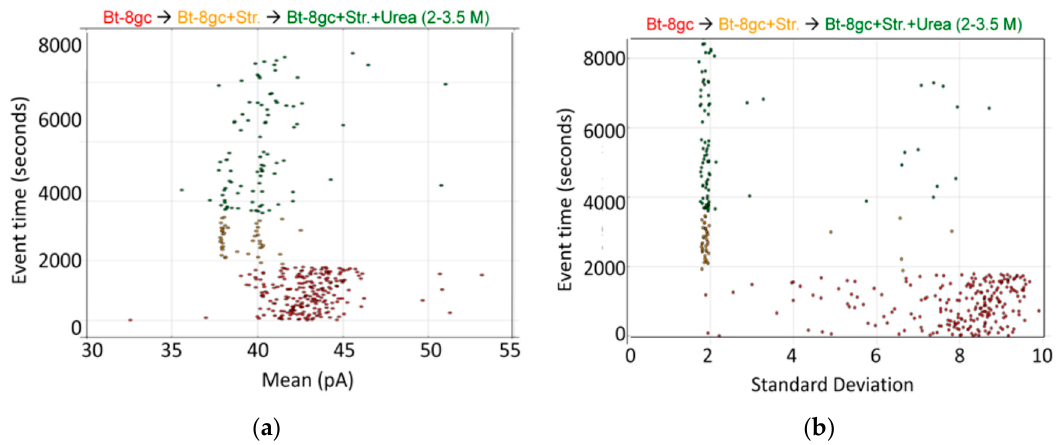
Figure 4. Biotinylated DNA hairpin transducer (Bt-8gc) in the presence of binding target (streptavidin) and chaotrope (urea). ( a ) Observations of individual blockade events are shown in terms of their blockade standard deviation (x-axis) and labeled by their observation time (y-axis) [20]. The standard deviation provides a good discriminatory parameter in this instance since the transducer molecules are engineered to have a notably higher standard deviation than typical noise or contaminant signals. At T = 0 s, 1.0 μ M Bt-8gc is introduced and event tracking is shown on the horizontal axis via the individual blockade standard deviation values about their means. At T = 2000 s, 1.0 μ M Streptavidin is introduced. Immediately thereafter, there is a shift in blockade signal classes observed to a quiescent blockade signal, as can be visually discerned. The new signal class is hypothesized to be due to (Streptavidin)-(Bt-8gc) bound-complex captures; ( b ) As with the Left Panel on the same data, a marked change in the Bt-8gc blockade observations is shown immediately upon introducing streptavidin at T = 2000 s, but with the mean feature we clearly see two distinctive and equally frequented (racemic) event categories. Introduction of chaotropic agents degrades first one, then both, of the event categories, as 2.0 M urea is introduced at T = 4000 s and steadily increased to 3.5 M urea at T = 8100